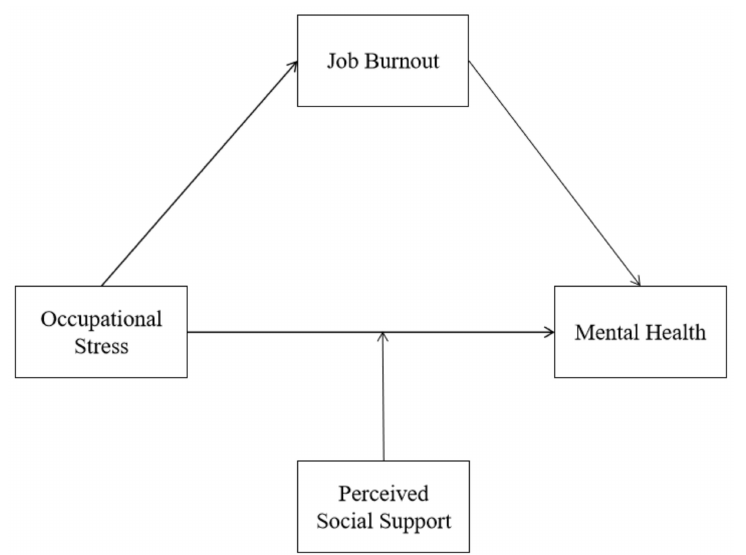
Figure 1. Hypothetical model of the association among occupational stress, mental health, job burnout, and perceived social